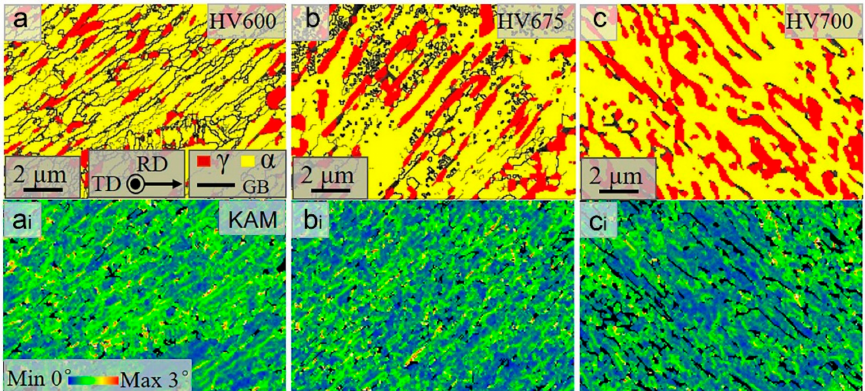
Figure 3. IQ phase maps for HV steel samples ( a – c ) and KAM maps for HV steel samples ( a i – c i ) annealed at different temperatures.